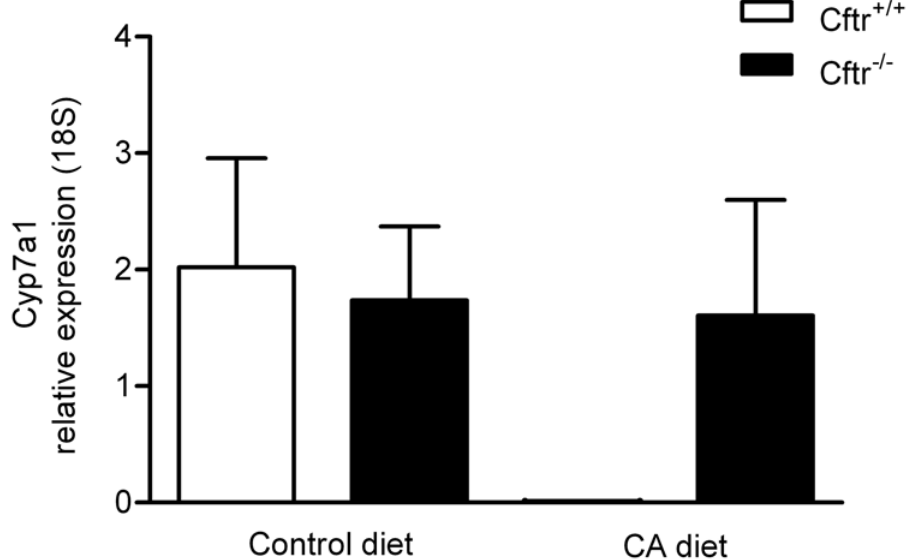
Fig 4. Body and liver weights in Cftr knockout, Δ F508 Cftr and control mice, fed a control diet or a cholic acid (CA) containing diet for 3 weeks. Body weight (A, B), absolute liver weight (C,D) and relative liver weight reported as a percentage of the body weight (E, F) in Cftr knockout mice ( Cftr -/- , panels A. C and E) or Δ F508 Cftr mice ( Cftr tm1EUR , panels B, D and F) and their respective control littermates ( Cftr +/+ ), after a control or 0.5%-CA (wt/wt) chow diet for three weeks. Data are presented as means ± SEM of N = 5 – 7 mice per group. * P-value <